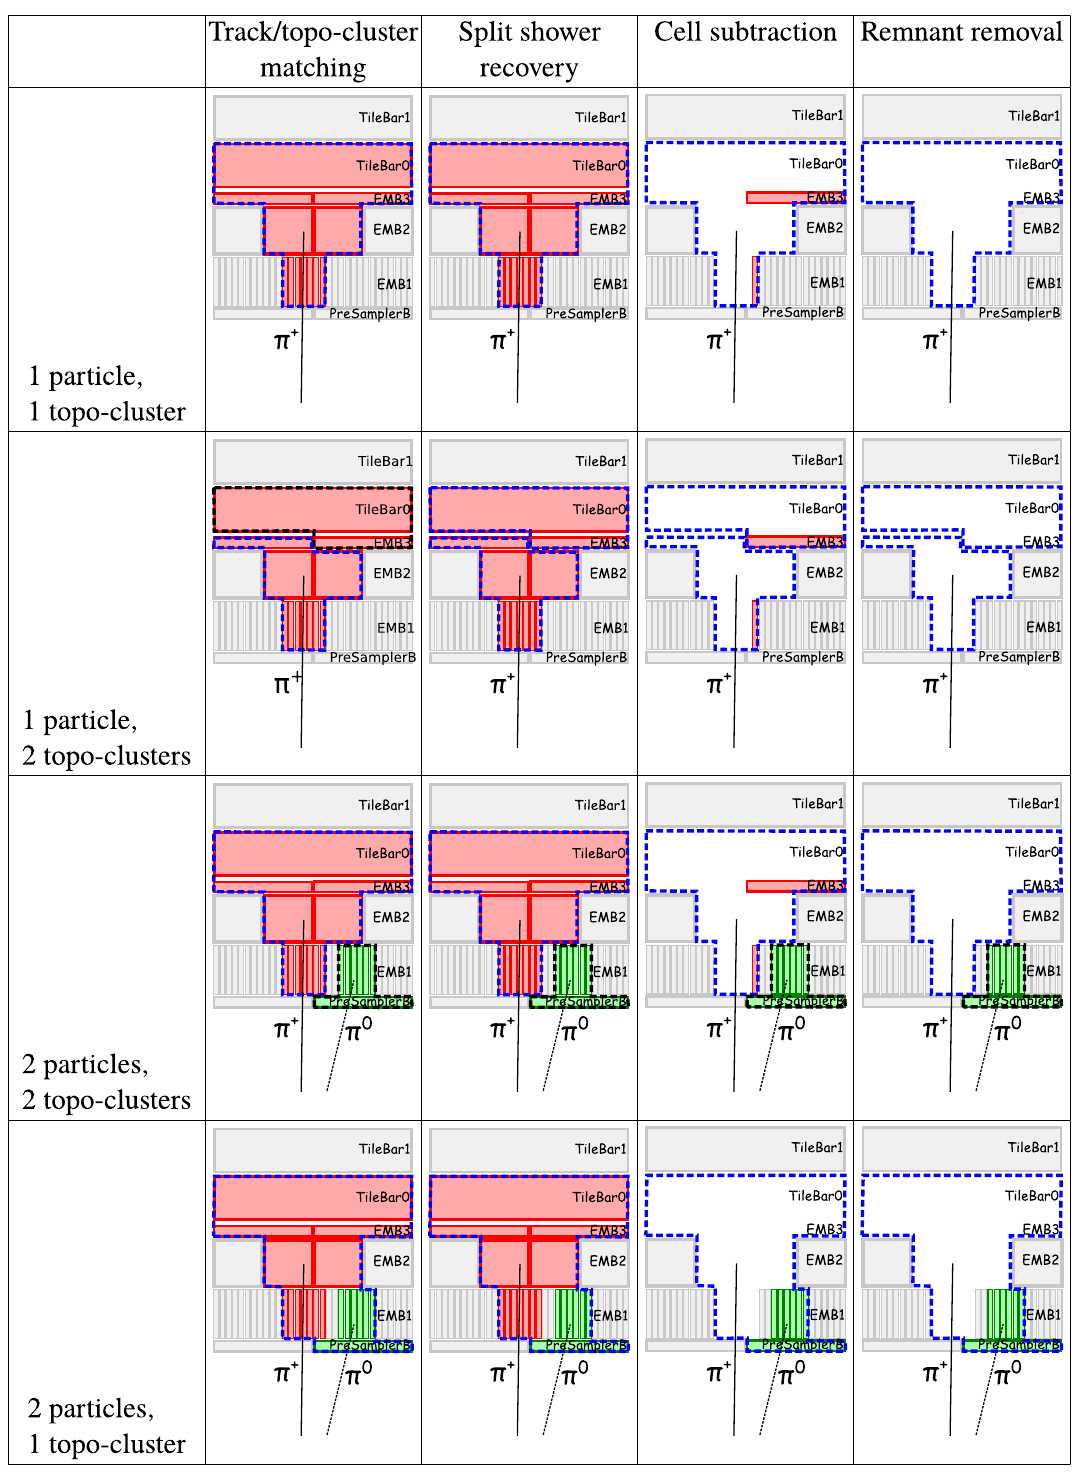
Fig. 3 Idealised examples of how the algorithm is designed to deal with several different cases. The red cells are those which have energy from the π + , the green cells energy from the photons from the π 0 decay, the dotted lines represent the original topo-cluster boundaries with those outlined in blue having been matched by the algorithm to